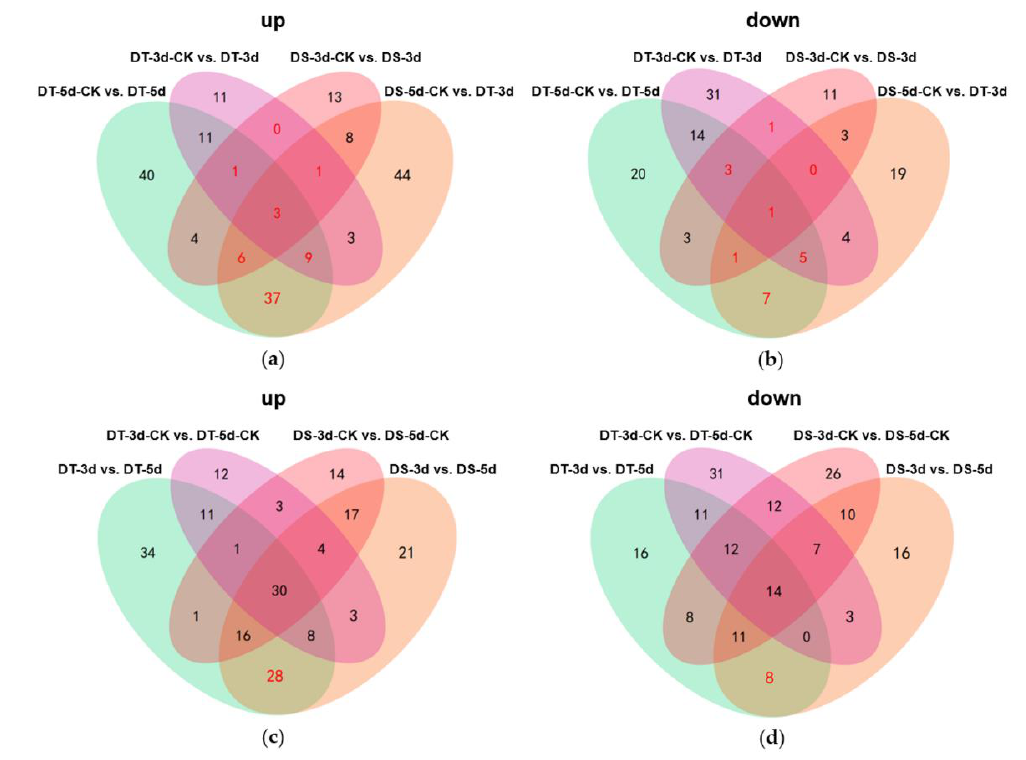
Figure 5. Venn diagrams showing the numbers of upregulated ( a , c ) and downregulated ( b , d ) differential metabolites (DMs) in different comparison groups. The metabolites labeled in red are considered as the drought − responsive metabolites.